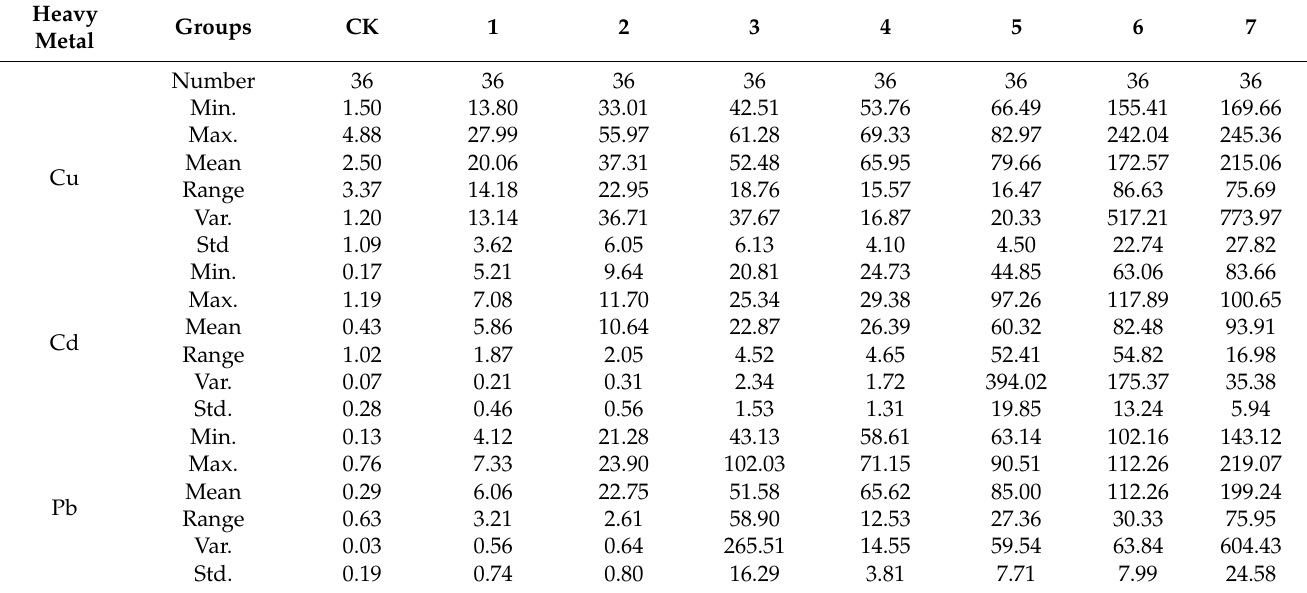
Table 1. Heavy metals (Cu, Cd and Pb) contents of Fritillaria obtained by ICP-MS.